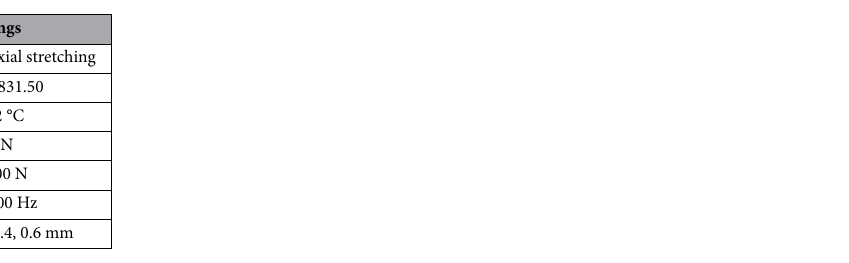
Table 1. Test parameters and